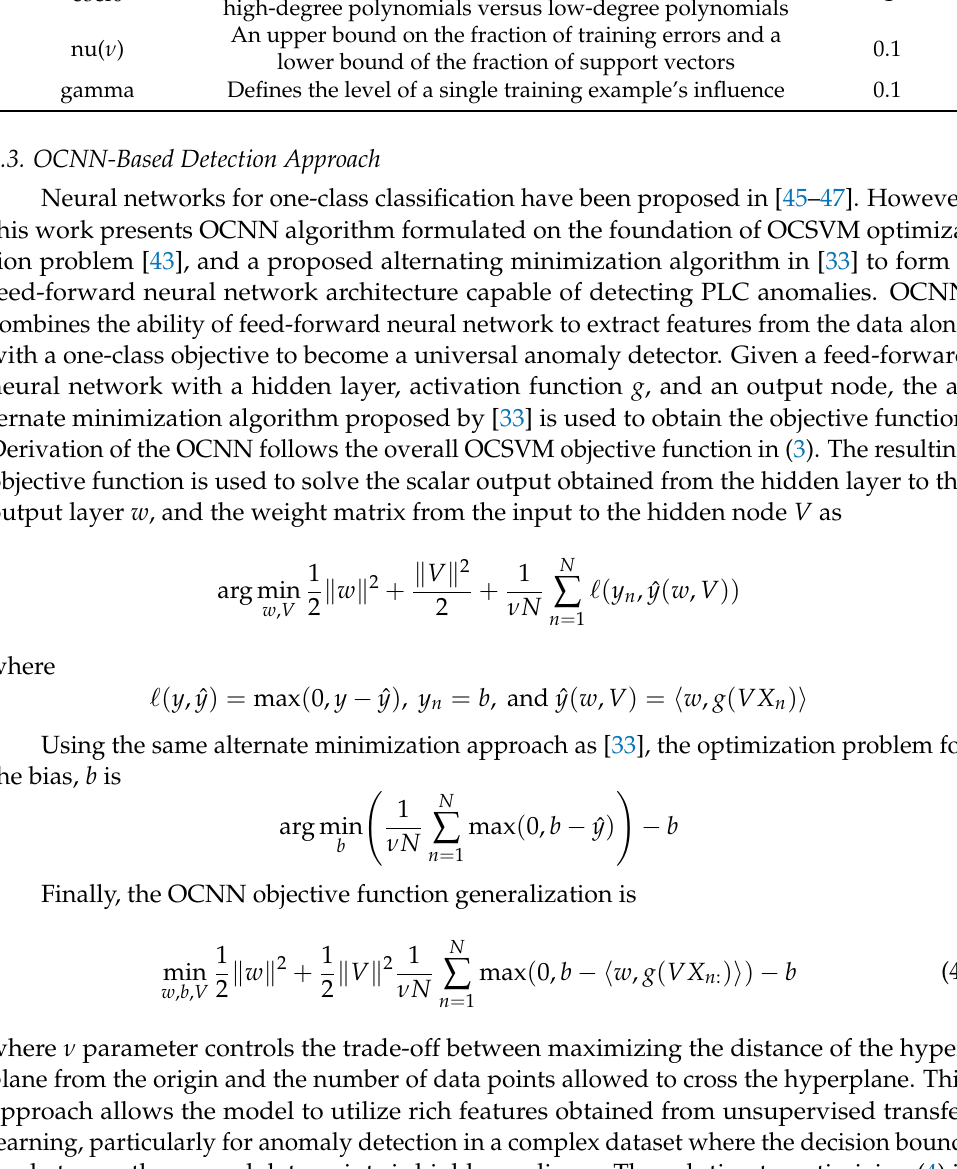
Table 2. Model hyperparameters for OCSVM. Parameter Description Choice kernel Type of kernel used in the algorithm polynomial